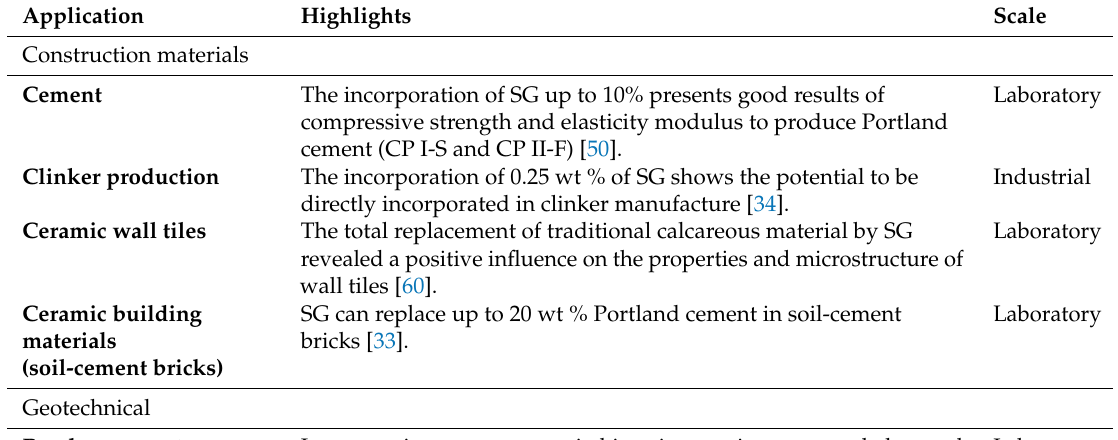
Table 7. Applications of SG reported in the